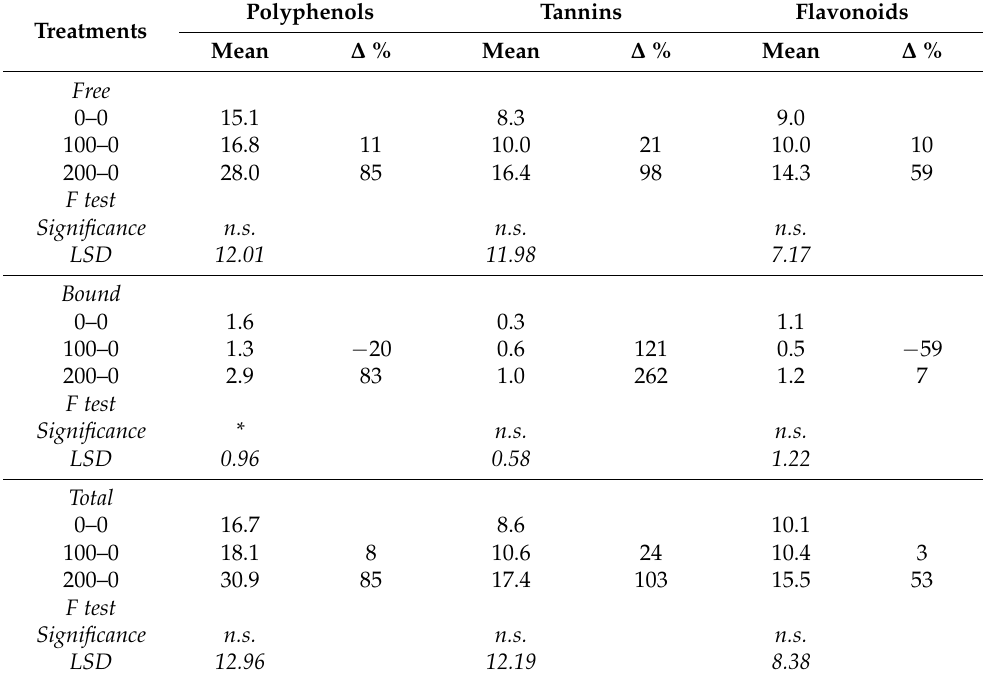
Table 4. Concentration (mg of gallic acid equivalent, GAE, per g − 1 DW) of the free, bound and total fractions of polyphenols, tannins and flavonoids in the rapeseed sprouts obtained from seeds harvested from mother plants grown under the three salinity treatments S0, S100 and S200 (i.e., 0, 100 and 200 mM of NaCl in the solution used for watering the pots throughout the whole